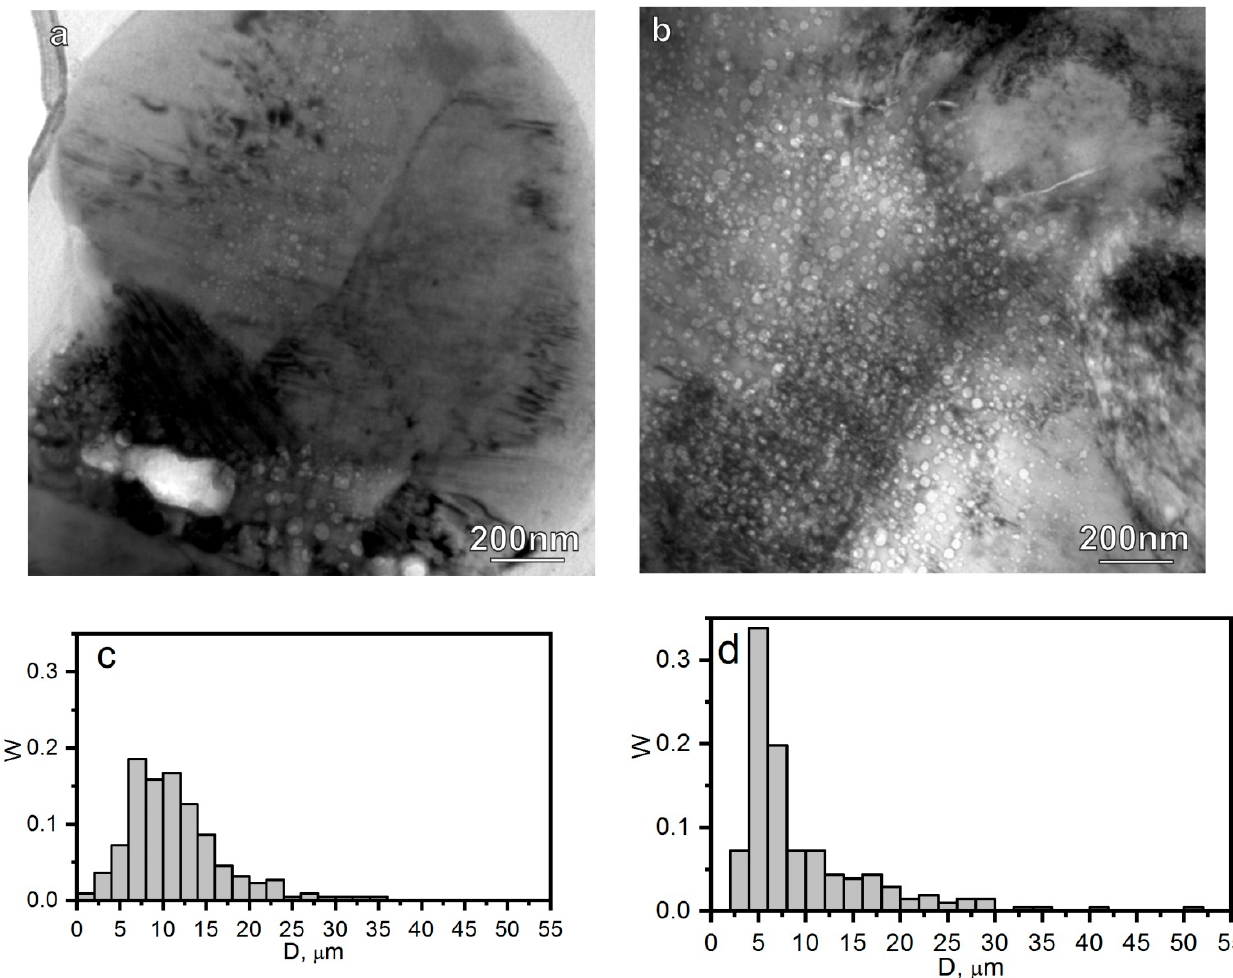
Figure 3. TEM images of the copper surface treated by titanium ions with pores: treatment during 6 min ( a ) and during 12 min ( b ). Pore size distribution for a sample with a treatment time of 6 min ( c ) and 12 min ( d ).